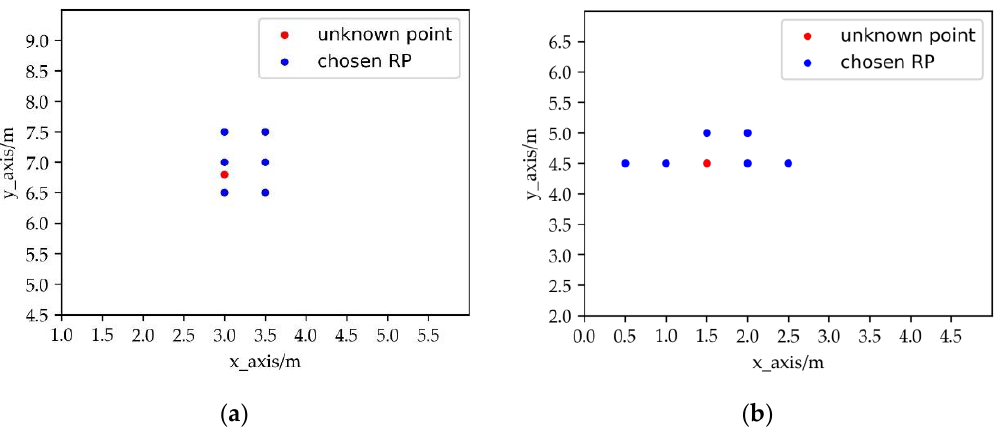
Figure 1. The normal distribution of reference points (RPs), where selected RPs gather around the unknown point in ( a ) and none of the selected RPs is significantly away from the cluster in ( b ).